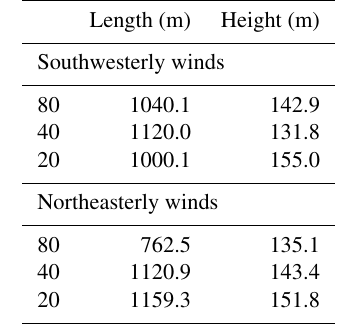
Table 6. Length and maximum depth of separation